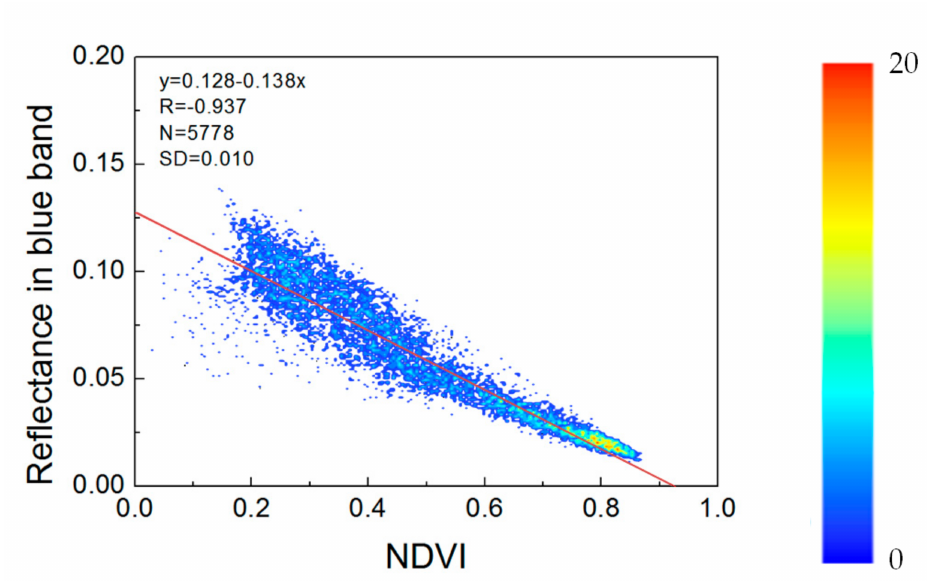
Figure 7. Scatter plot of the Normalized Difference Vegetation Index (NDVI) versus reflectance in the blue band.